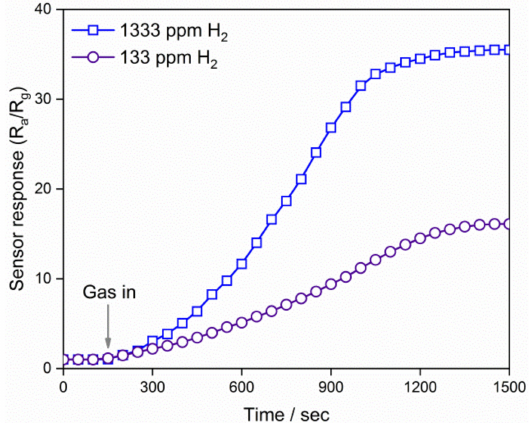
Figure 8. Gas-sensing characteristics of the thin film prepared from the QD0 solution at room